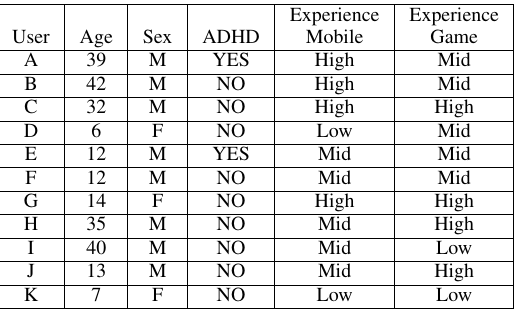
Table I: Test Group